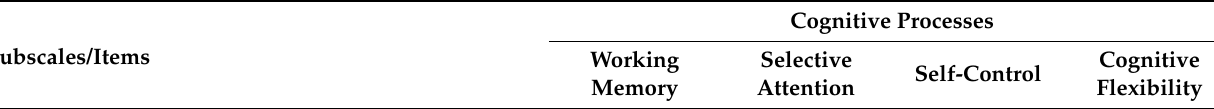
Table 1. Associations Between Cognitive Processes and Individual Items for Subscales of Attentional Function